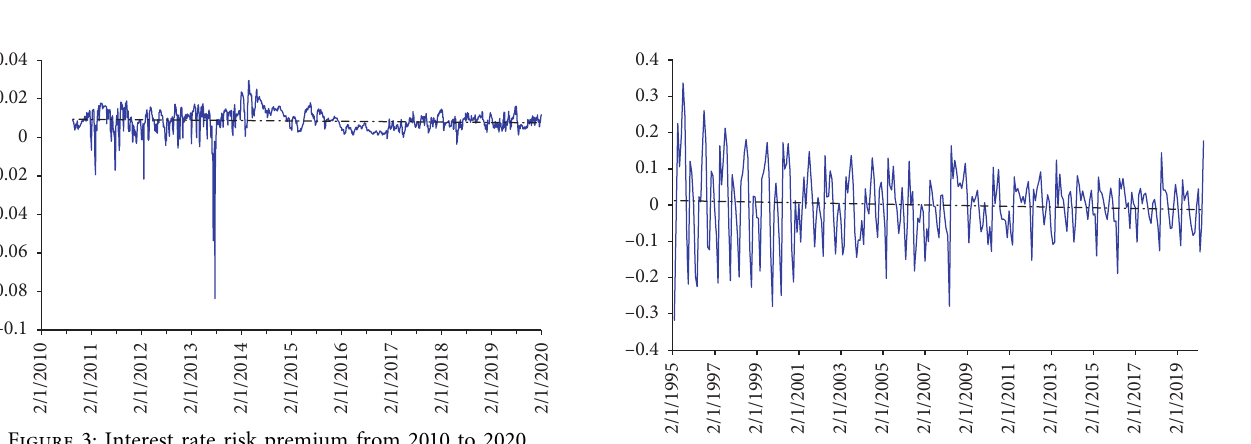
Figure 4: Inflation risk premium from 1995 to